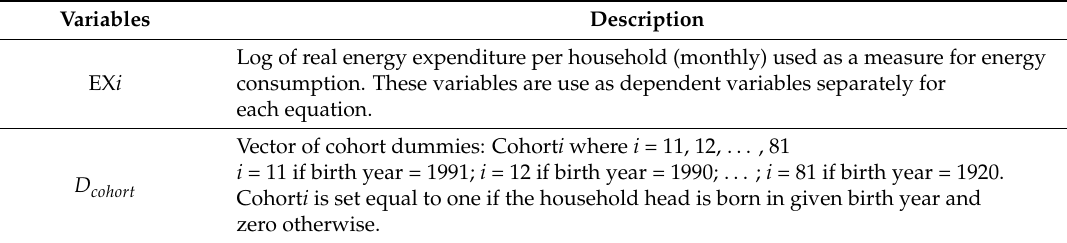
Table 5. Variables